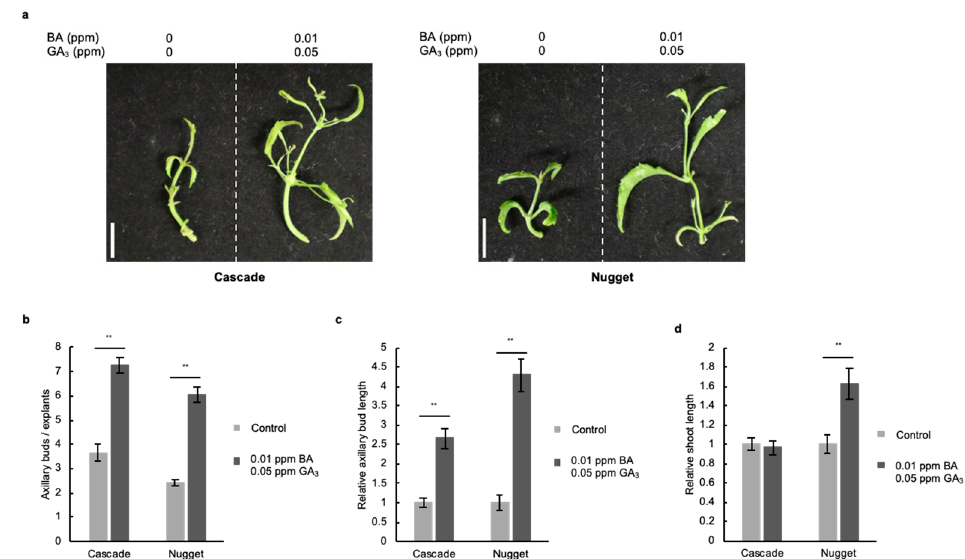
Figure 5. The development of axillary buds is enhanced with gibberellic acid (GA 3 ) and BA in various hop cultivars. ( a ) Stem explants of the hop cultivars Cascade and Nugget were treated with 0.01 ppm BA and 0.05 ppm GA 3 for 3 weeks. Scale bars: 1 cm. ( b ) Number of axillary buds in stem explants treated with 0.01 ppm BA and 0.05 ppm GA 3 for 3 weeks ( n ≥ 9, individual experiment, p < 0.01; Student’s t test). ( c ) Relative axillary bud length of stem explants treated without and with 0.01 ppm BA and 0.05 ppm GA 3 for 3 weeks. The axillary bud length of explants treated with 0.01 ppm BA and 0.05 ppm GA 3 was normalized against the axillary bud length of explants without BA and GA 3 ( n ≥ 12, individual experiment, ** p < 0.01; Student’s t test). ( d ) Relative shoot length of stem explants treated without and with 0.01 ppm BA and 0.05 ppm GA 3 for 3 weeks. The shoot length of explants treated with 0.01 ppm BA and 0.05 ppm GA 3 was normalized against the shoot length of explants without BA and GA 3 ( n ≥ 10, individual experiment, ** p < 0.01; Student’s t test).